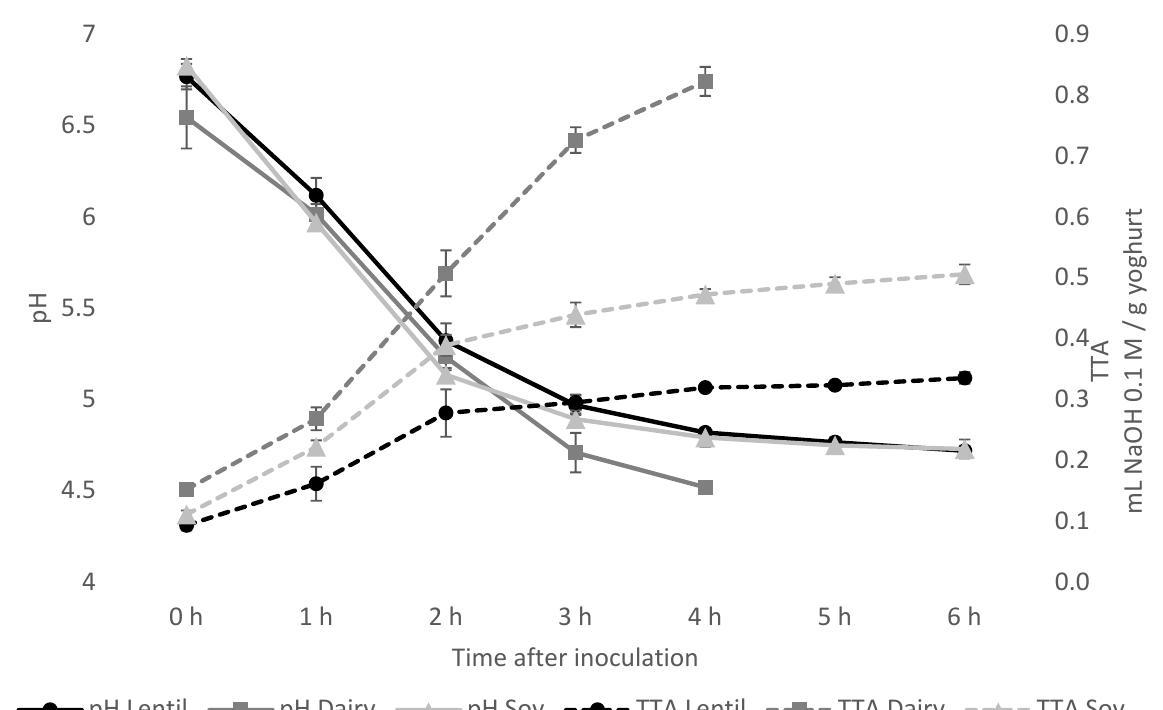
Figure 1. Acidification during fermentation as measured by pH (solid lines) and total titratable acidity (TTA) in ml NaOH 0.1 M per g of yoghurt (dashed lines). The fermentation was ended if a pH of 4.5 was reached, or the pH did not drop significantly in 2 consecutive measurements 1 h apart. Fermentation of dairy controls was ended after 4 h, so no data points for 5 h and 6 h are given for dairy controls.